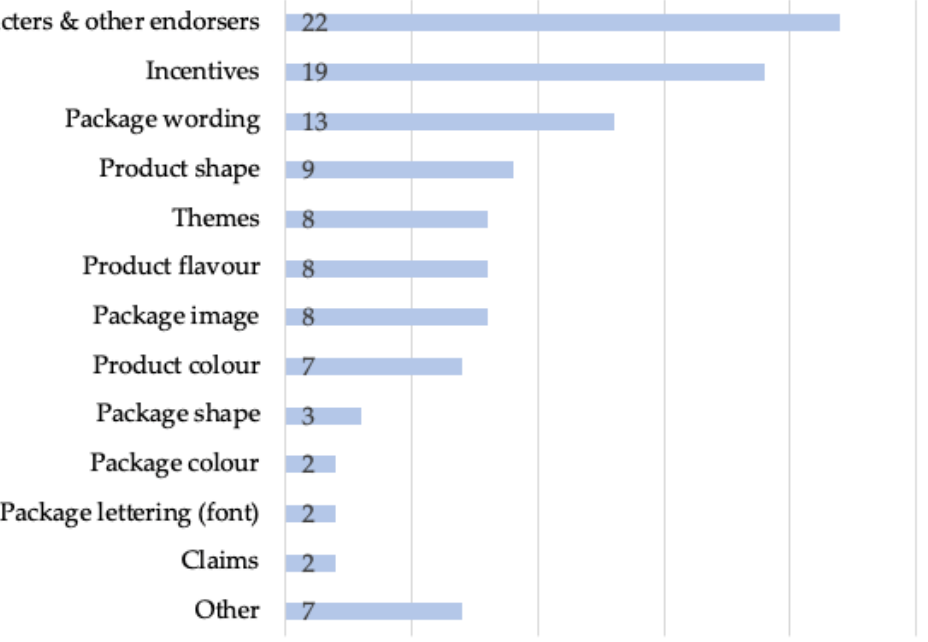
Figure 2. Frequency of child-targeted food packaging indicators tracked by content analyses ( n = 22). Cartoon characters and other endorsers (which includes brand mascots, licensed cartoon